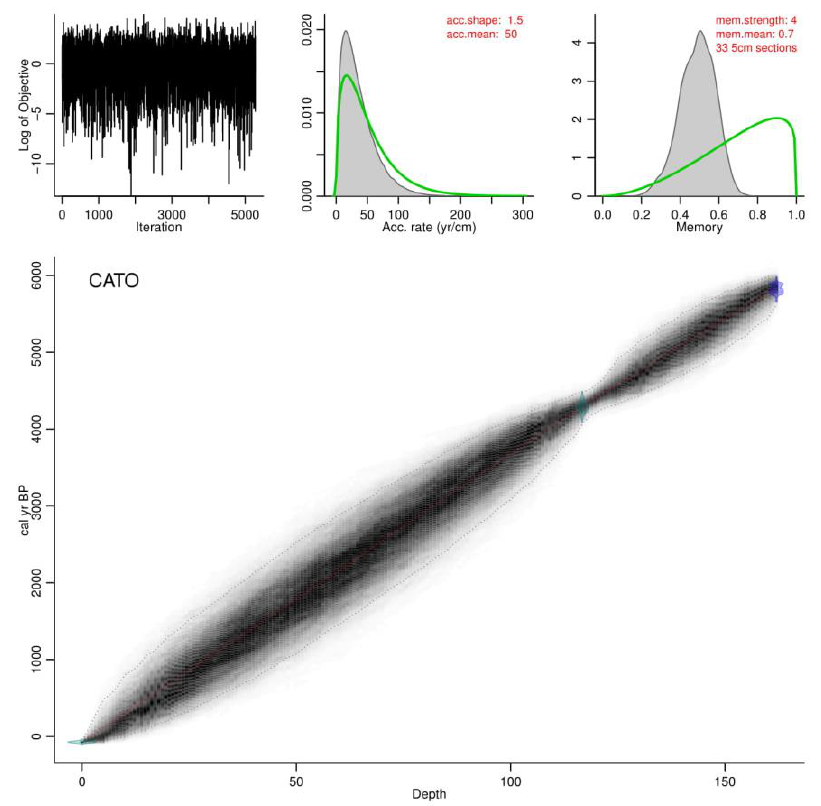
Figure A3f. Age-depth model produced in BACON for